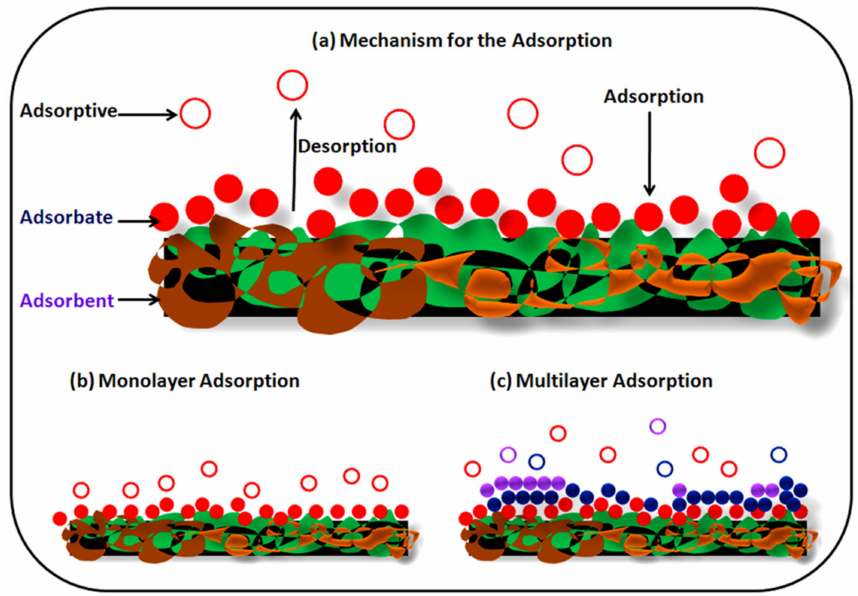
Figure 2. ( a ) General mechanism for the adsorption, ( b ) monolayer adsorption, and ( c ) multilayer